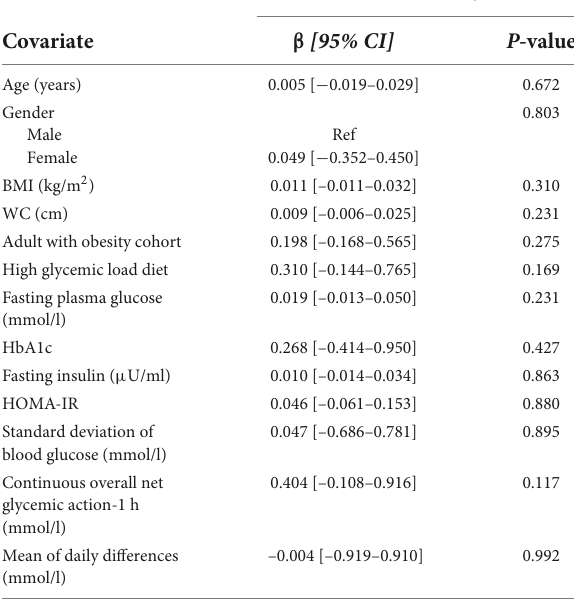
TABLE 3 Univariate linear regression analysis of factors associated with mean amplitude of glycemic excursions (MAGE). Univariate